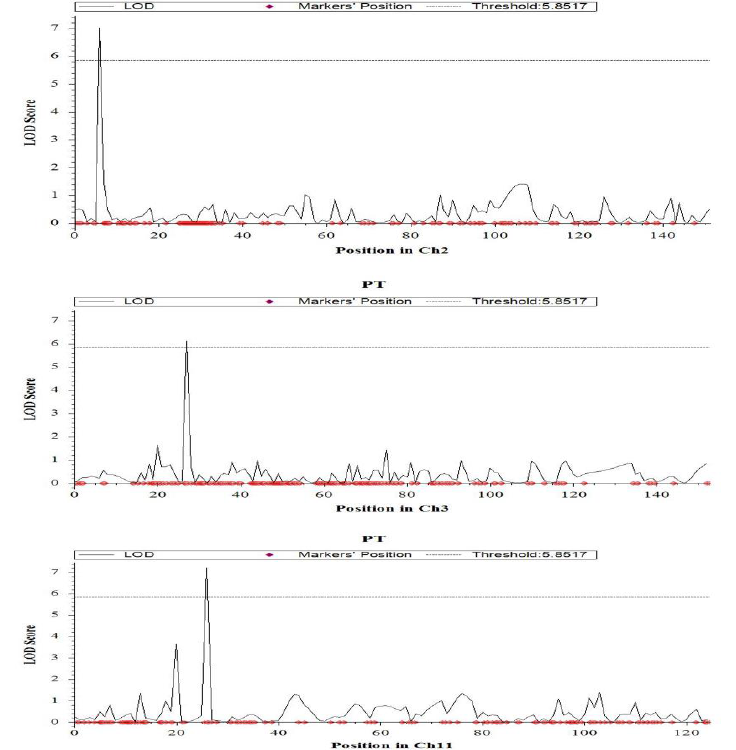
Figure 6. Chromosome locations of QTLs for productive tillers per plant under salinity stress based on a significance threshold of LOD 3.0 using ICIMapping on chromosomes 2, 3, and 11. The horizontal line indicates the significant LOD threshold at 95% confidence levels based on 1000